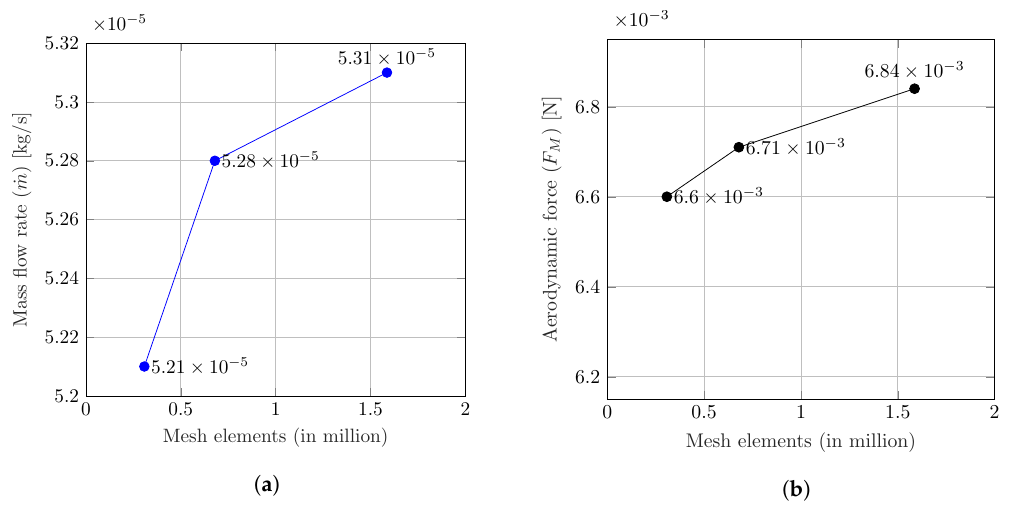
Figure 7. Grid independence analysis: ( a ) mass flow rate; ( b ) total axial